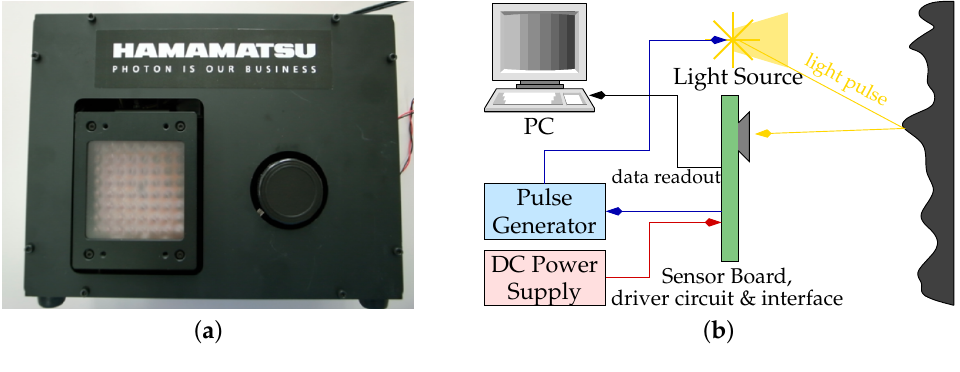
Figure 4. The Hamamatsu PB-ToF prototype. ( a ) External view on the Hamamatsu camera; ( b ) The main components of the Hamamatsu